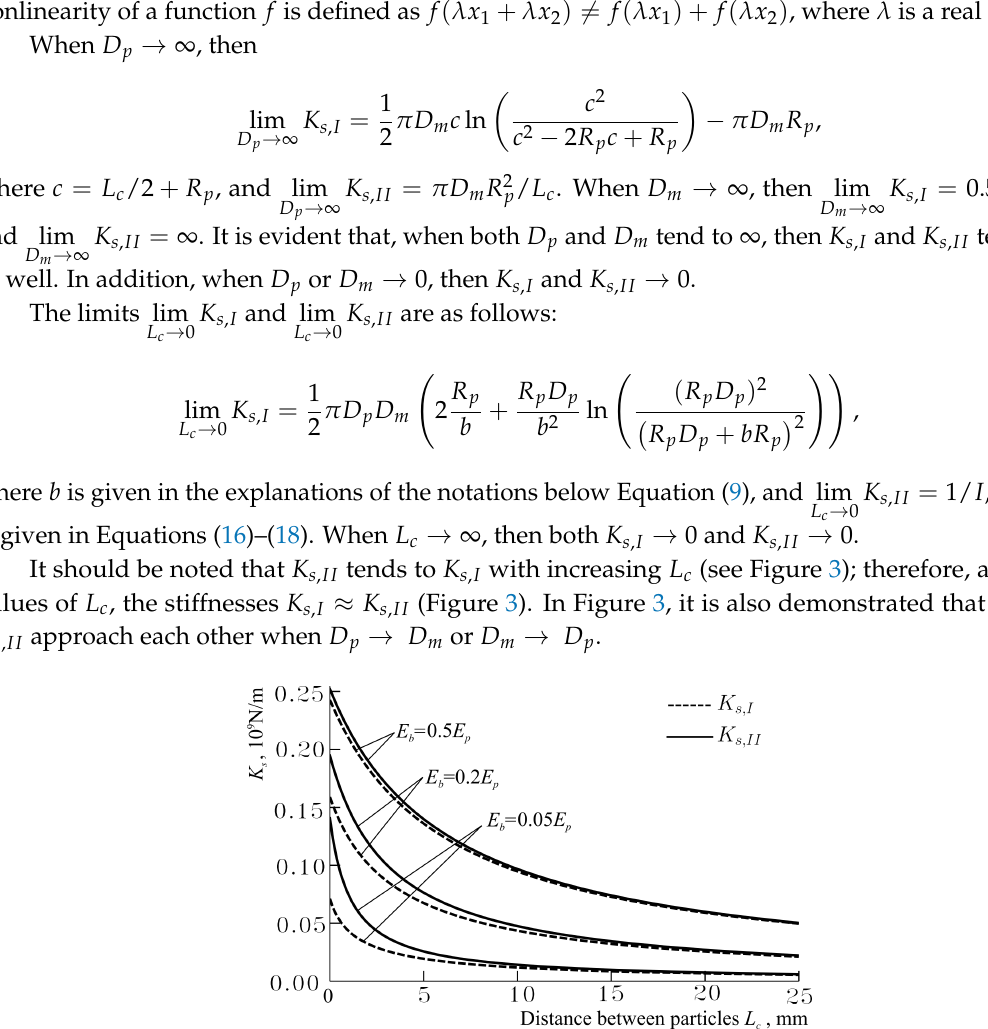
Figure 3. Dependences of the stiffnesses K s , I and K s , II on the distance between particles’ surfaces L c at different modulus of elasticity of interface member E m as D p = E p = 40 GPa, R p = 5 mm, D m = E m ∈ { 0.05 E p ,0.2 E p ,0.5 E p }